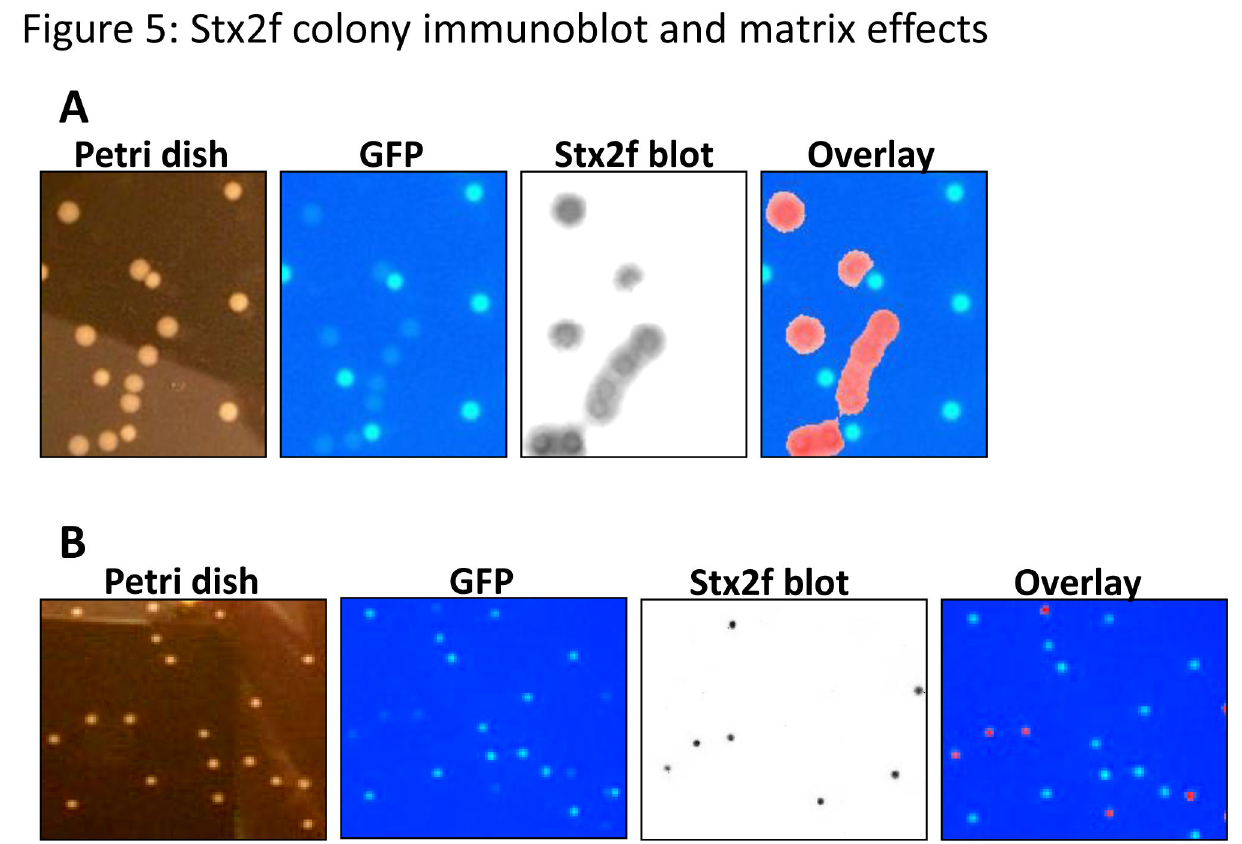
Figure 5. Stx2f colony immunoblot and matrix effects. A. A Stx2f colony immunoblot using mAb Stx2f-4 was conducted upon a mixture of Stx2f-expressing cells and GFP-labeled control cells. The cells were diluted 10 6 and plated on LB +50 ng/mL mitomycin C. The same petri dish portion is displayed for all four panels (Petri dish, GFP, Stx2f blot, and Overlay). B. A Stx2f colony immunoblot is shown using the same mixture of cells as in 5A, plated on an LB plate containing mitomycin C and supplemented with 50 µL of chicken breast extract. The same petri dish portion is displayed for these four panels. doi: